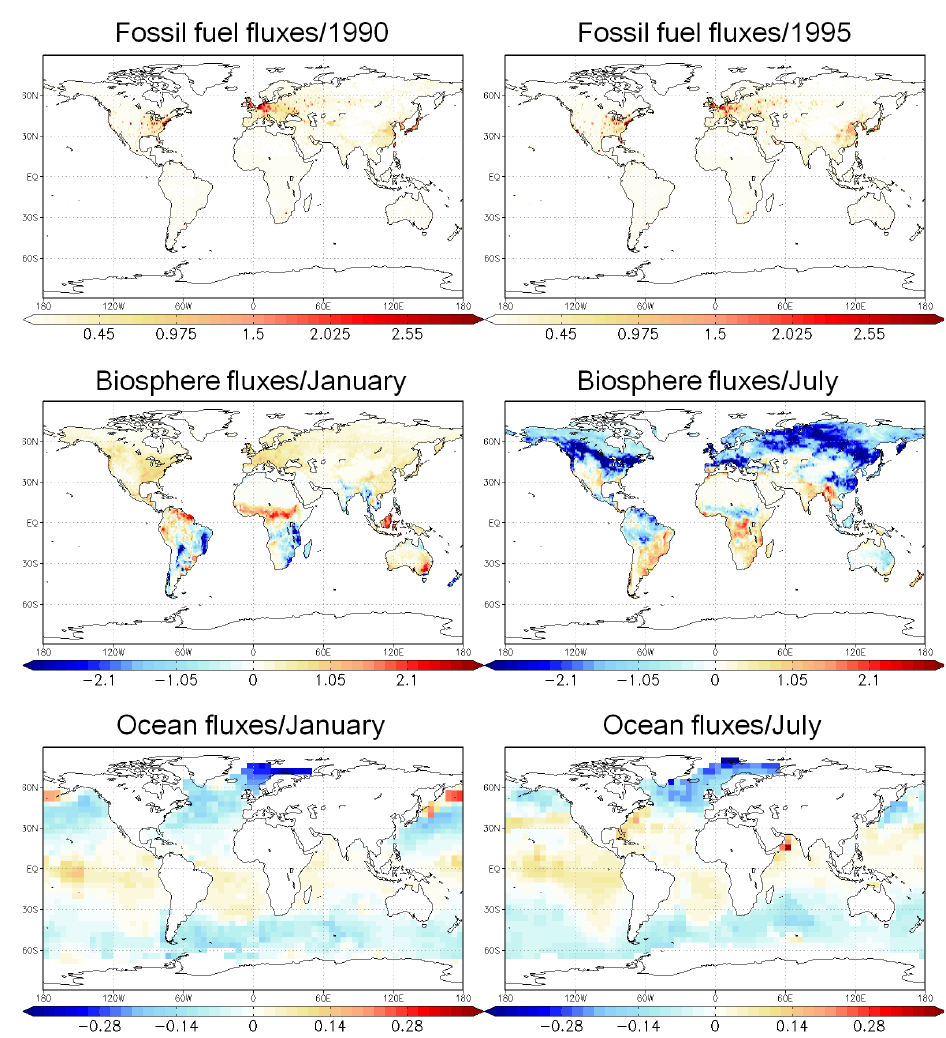
Fig. 1. A fixed “presubtracted” average emission fields in units of gm − 2 day − 1 from T3 experiment for three different emission sources: fossil fuel (top figures, year data), biosphere exchange (middle figures, monthly data), ocean exchange (bottom figures, monthly